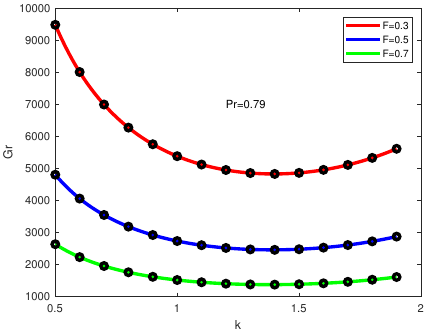
Figure 10. Marginal stability curves for Pr = 0.79 (Case